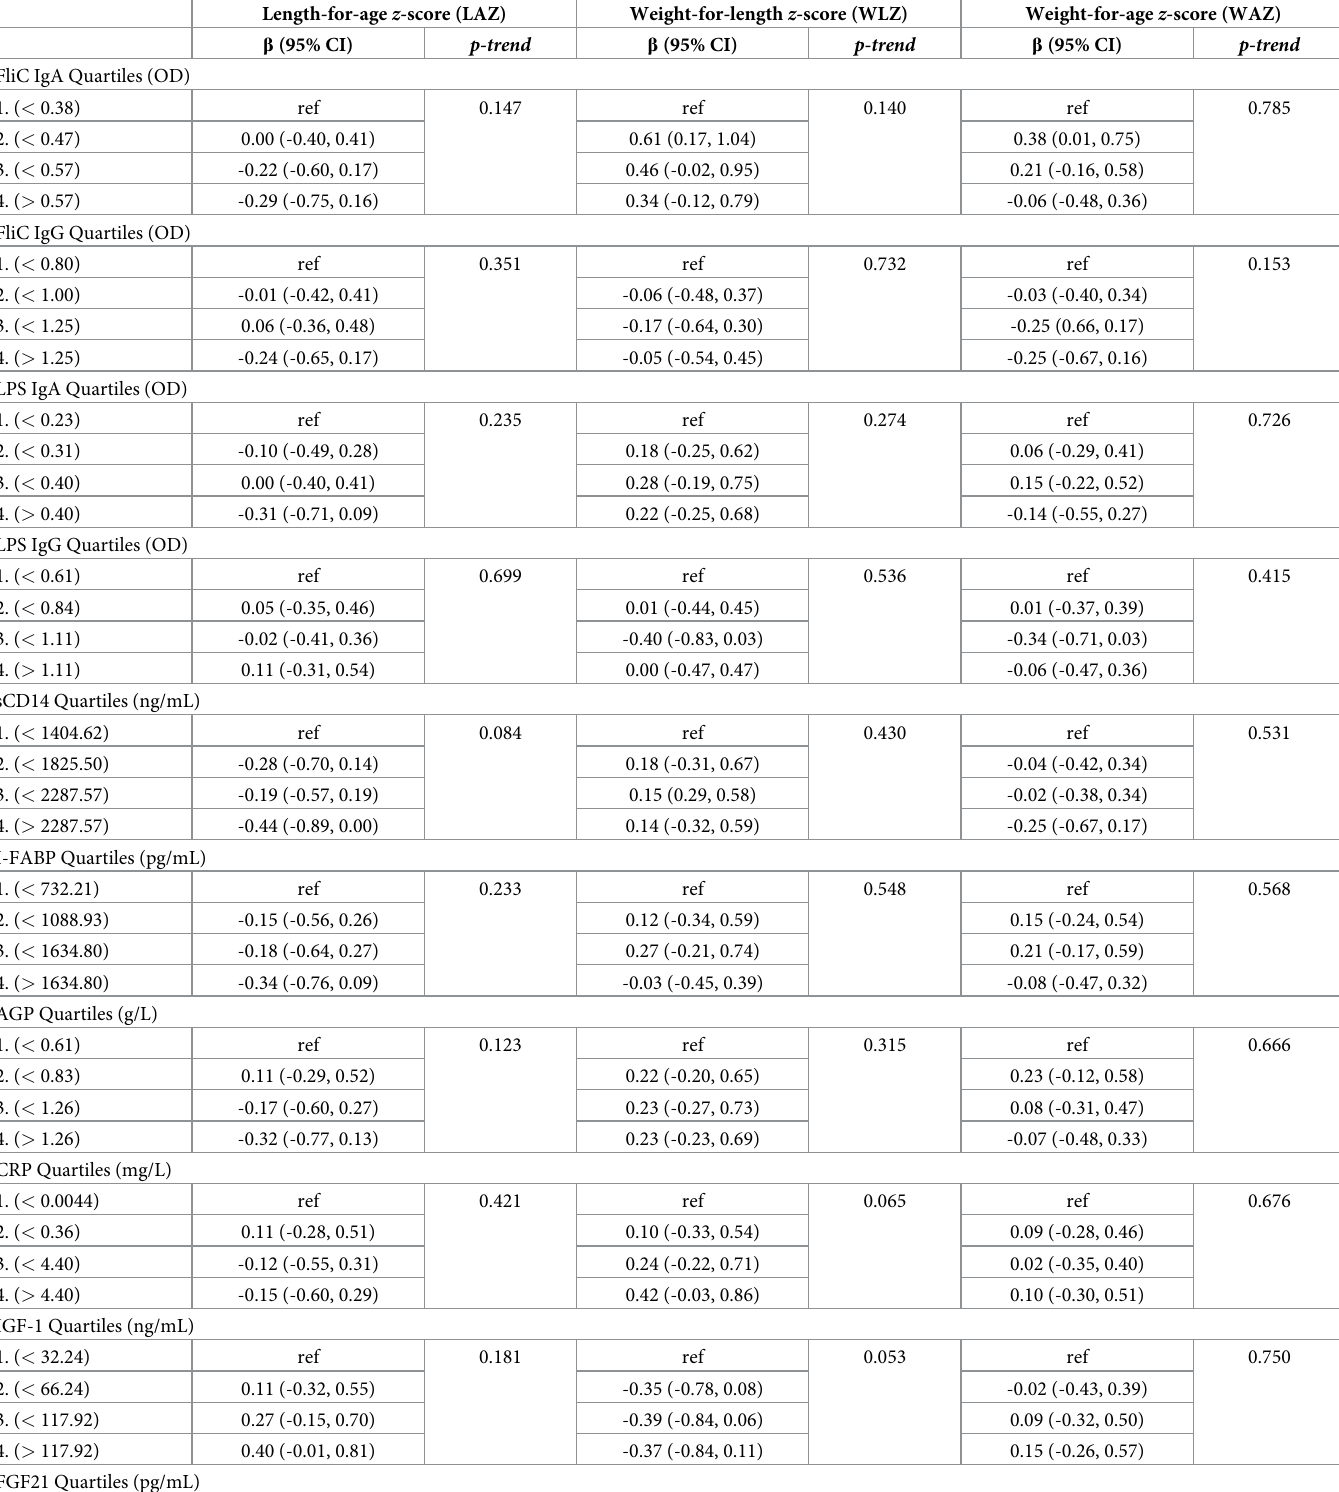
Table 3. Biomarker concentrations (quartiles) at 6 weeks of age and associations with growth outcomes at 12 months of age 1 . Length-for-age z -score